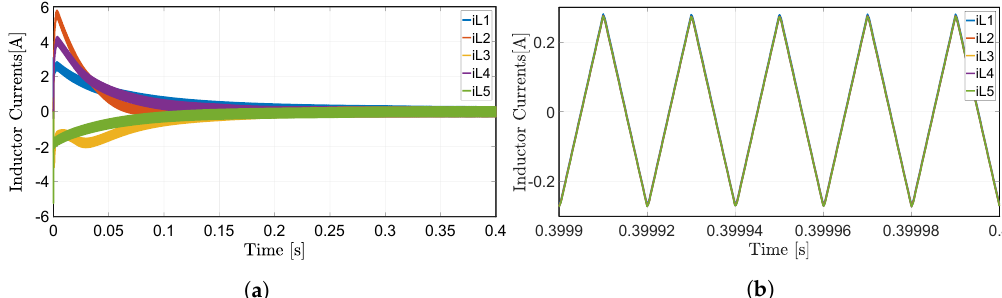
Figure 13. ( a ) Inductor currents of the proposed ´cuk balancing circuit with eight cells; and ( b ) inductor currents of the proposed ´cuk balancing circuit with eight cells in steady-state.